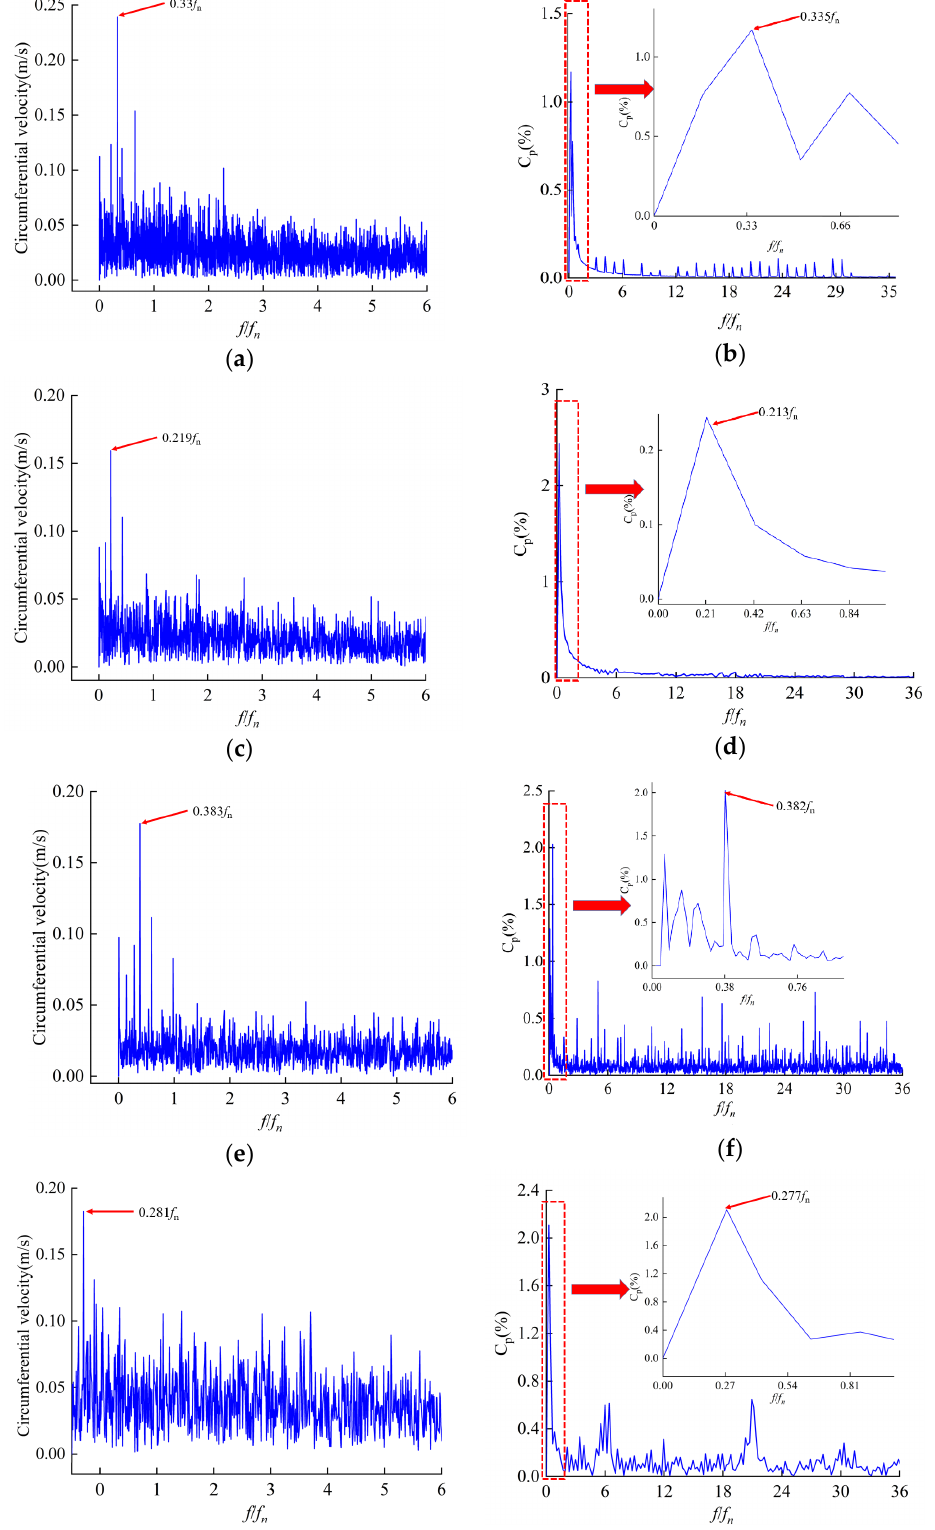
Figure 21. FFT results of circumferential velocity and pressure pulsation (LDV measuring point position is 0.2R). ( a ) Circumferential velocity of OP2, ( b ) pressure pulsation of OP2, ( c ) circumferential velocity of OP3, ( d ) pressure pulsation of OP3, ( e ) circumferential velocity of OP5, ( f ) pressure pulsation of OP5, ( g ) circumferential velocity of OP6, and ( h ) pressure pulsation of OP6.